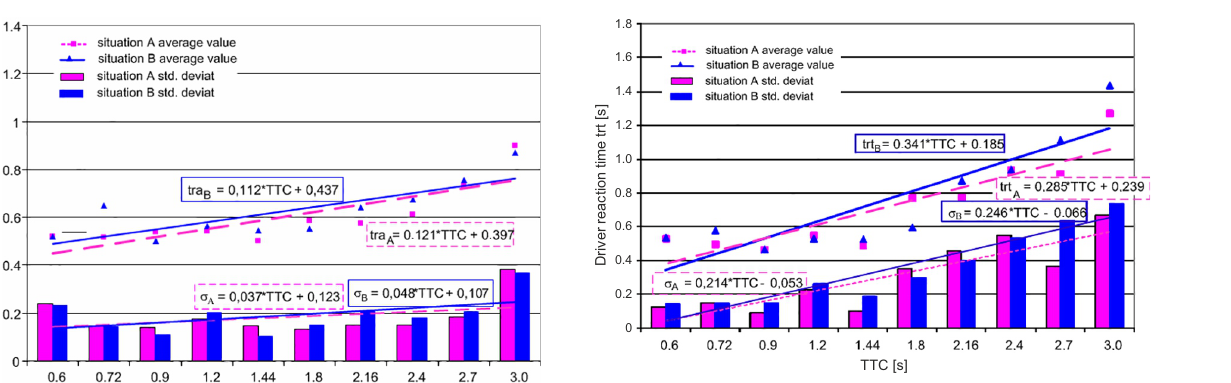
Fig. 14. The values of obtained reaction times to turning – trt